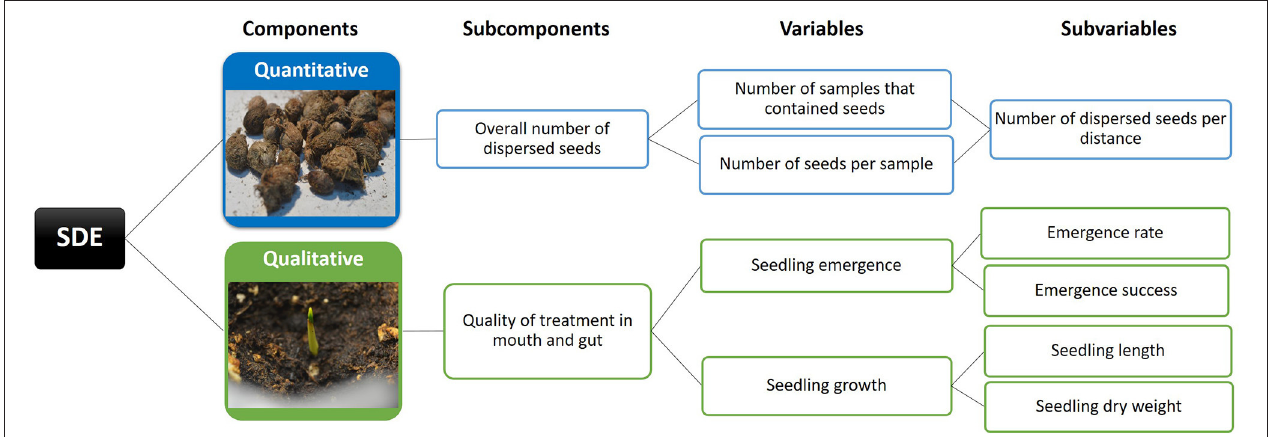
FIGURE 2 | Summary of methods used to assess each of the SDE (Seed Dispersal Effectiveness) components: quantitative and qualitative ( sensu Schupp et al.,